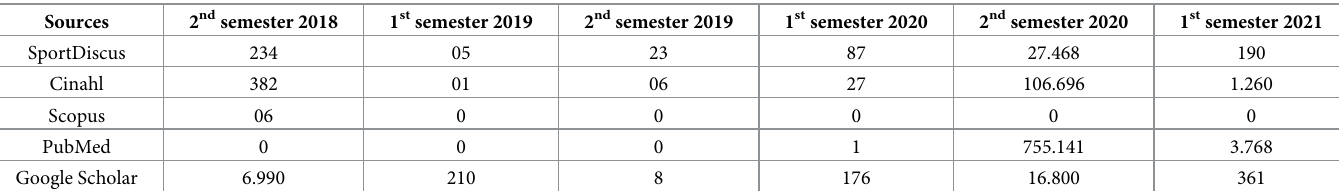
Table 1. Results of the number of articles selected by search steps.